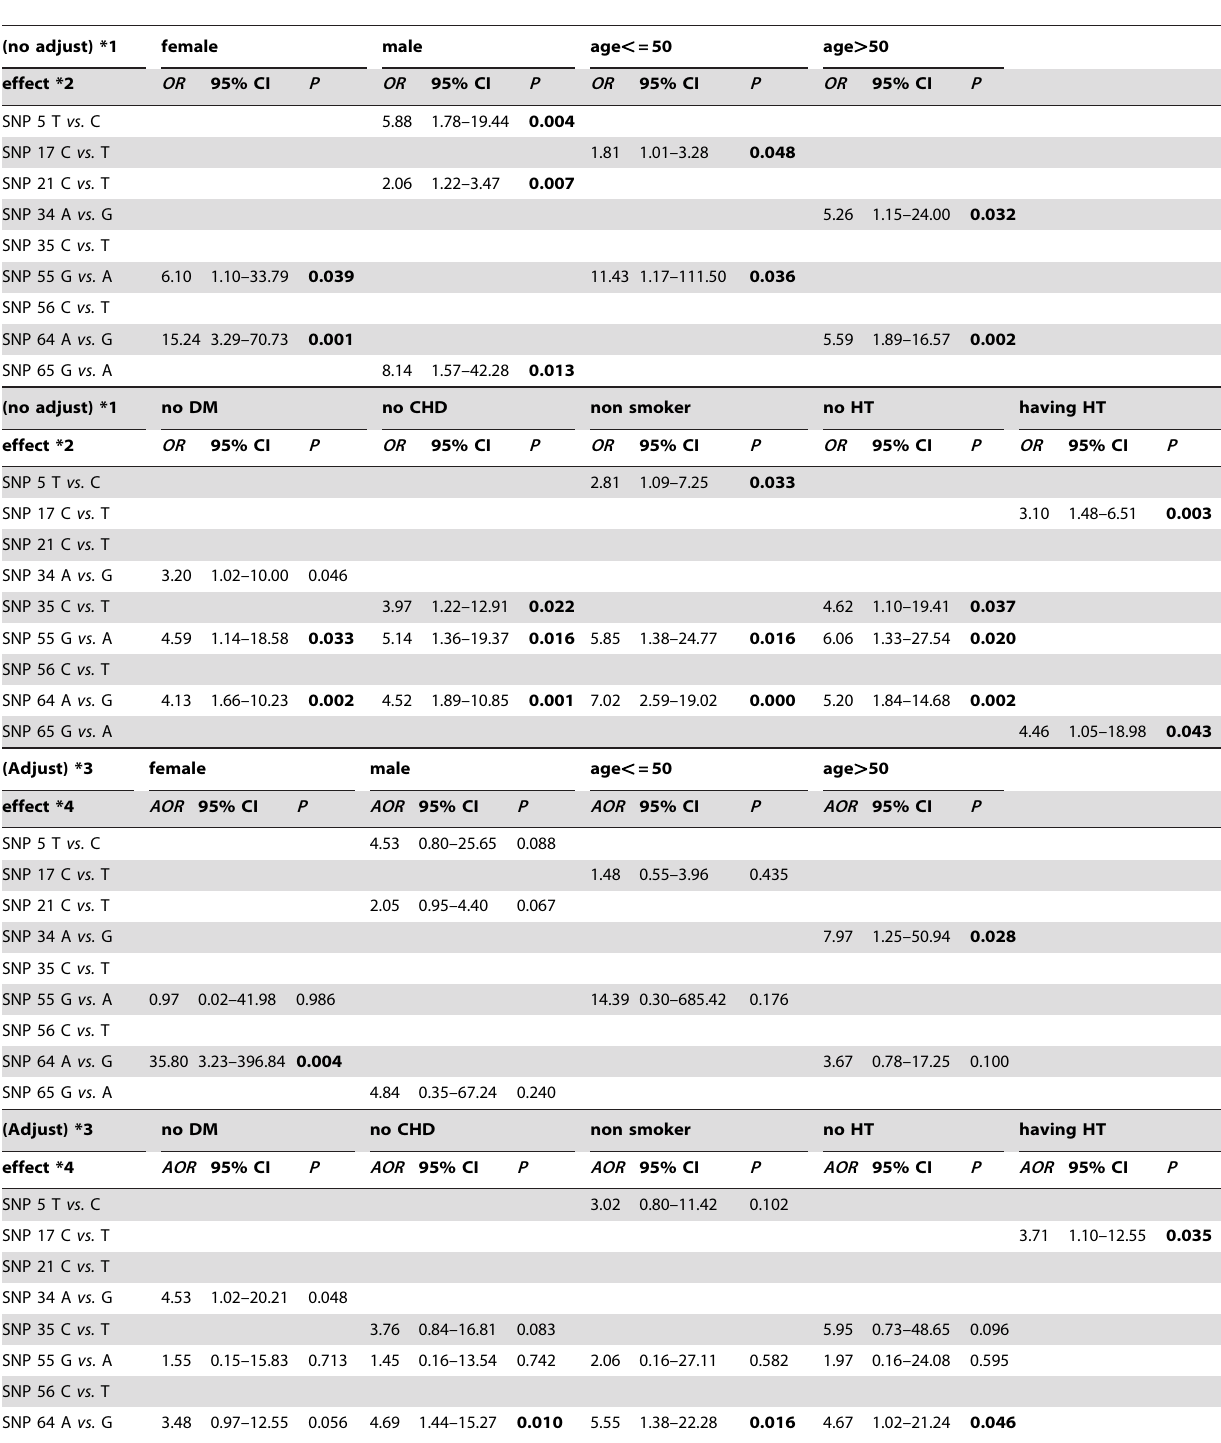
Table 5. The OR and AOR for the 9 SNPs selected by backward logistic regression for subgroups related to several basic demographic